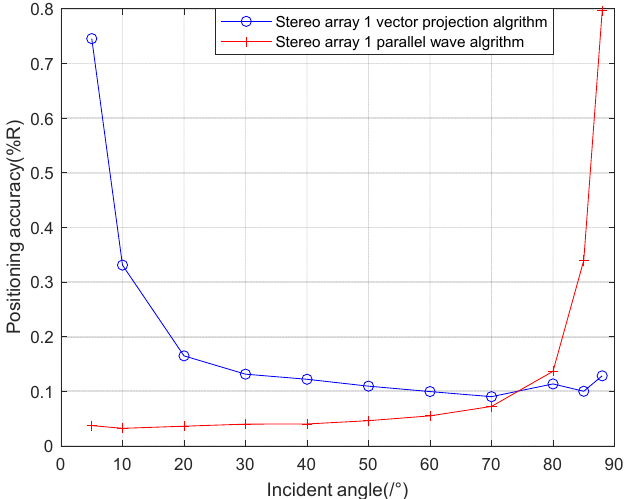
Figure 12. Positioning accuracy of stereo array 1 at different incident angles.